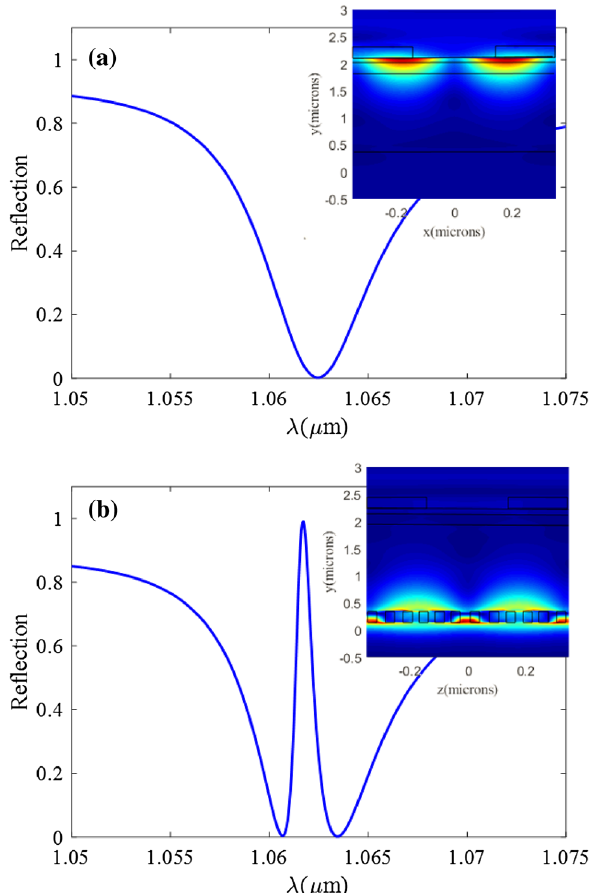
Figure 2. Reflection spectra and electric field distribution. ( a ) The reflection spectrum of the structure without Si SWG. The inset shows the electric field distribution at the wavelength of λ = 1063 nm. ( b ) The reflection spectrum of structure with Si SWG. The inset depicts the electric field distribution at λ = 1061.6 nm. The figures are calculated for the geometrical parameters of Λ PMMA = 700 nm, W PMMA = 320 nm, h PMMA = 250